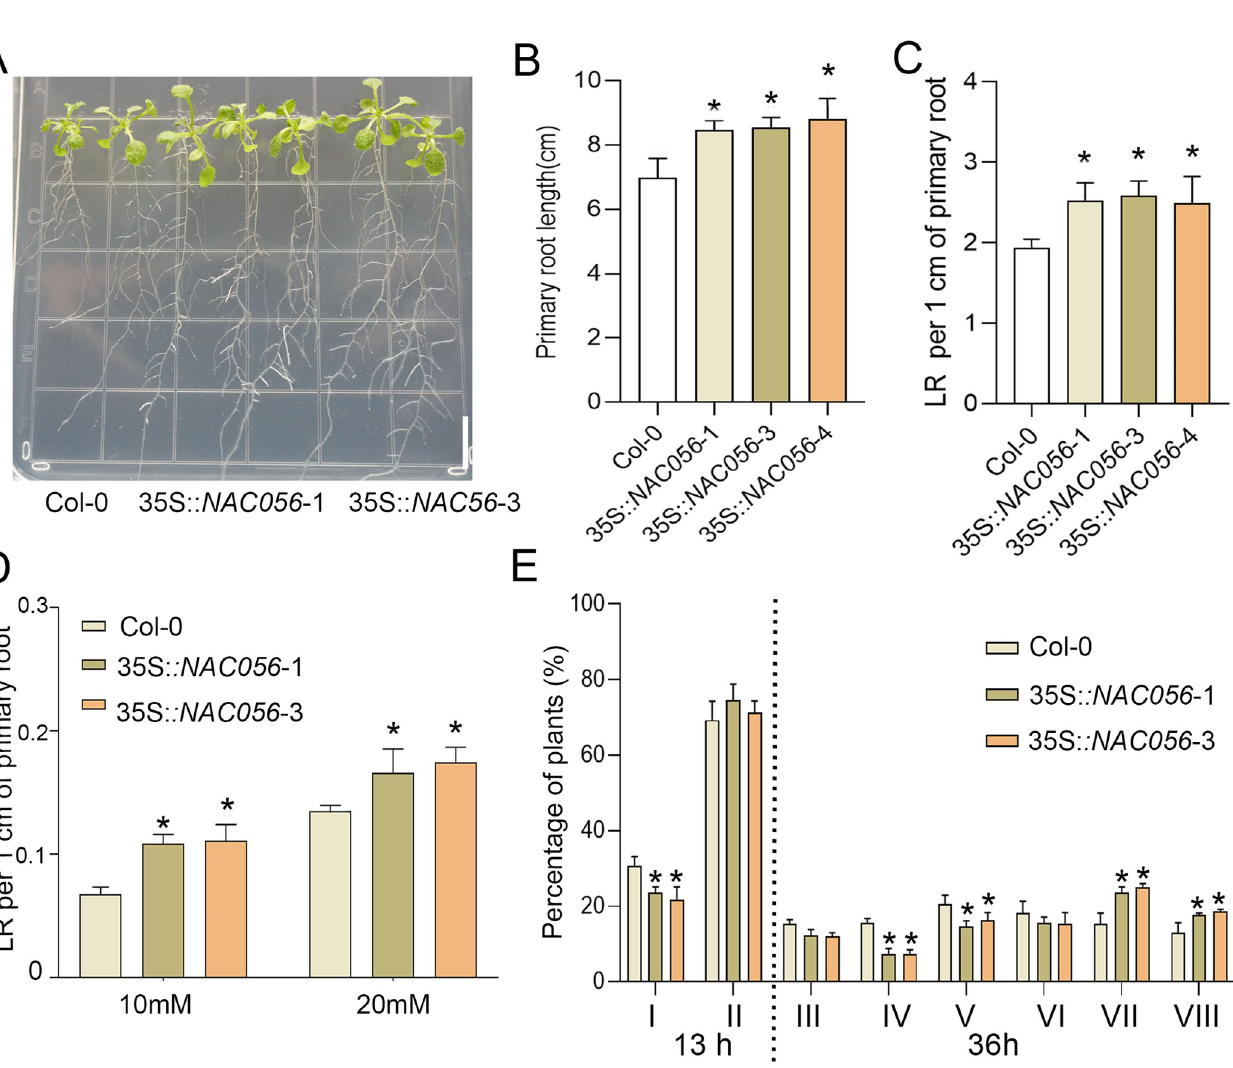
Fig 8. 35S:: NAC056 promoted LR growth and increased low-nitrate tolerance. Root phenotype observation and analysis (B) primary root length; (C) LR density in ten days old Col-0 and NAC056 -overexpressed lines. Values are given as mean ± standard error (SE), n = 3. � p < 0.05 by Student’s t test. D. Col-0 and transgenic plants were grown vertically in nitrogen- deficient medium supplemented with 10 μ M or 20 μ M nitrate for 9 d. Average LR density was quantified. Data points are mean ± SE. Values are given as mean ± SE, n = 3. � p < 0.05 by Student’s t test. E, Phenotypic analysis of LRE was achieved by synchronizing LR formation with gravitropic stimulus for 13 h and 36 h. Compared with the WT, the transgenic plants showed increased LRE. The data are shown as percentages, and the error bars represent SDs (n = 6–12). At least 90 total LRPs were observed for each sample.